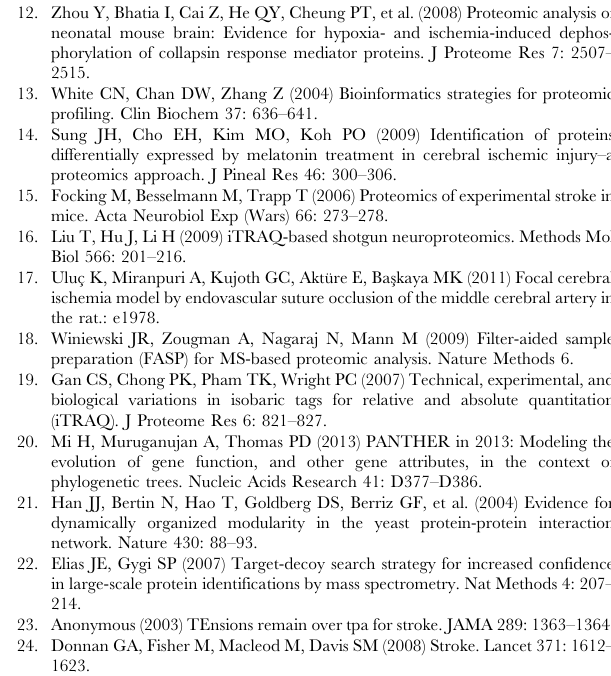
Table S1 Output of false discovery rate (FDR) charac- teristics for identified peptides and proteins. Table S2 Output of relative protein expression changes between iTRAQ labels 113/114 and